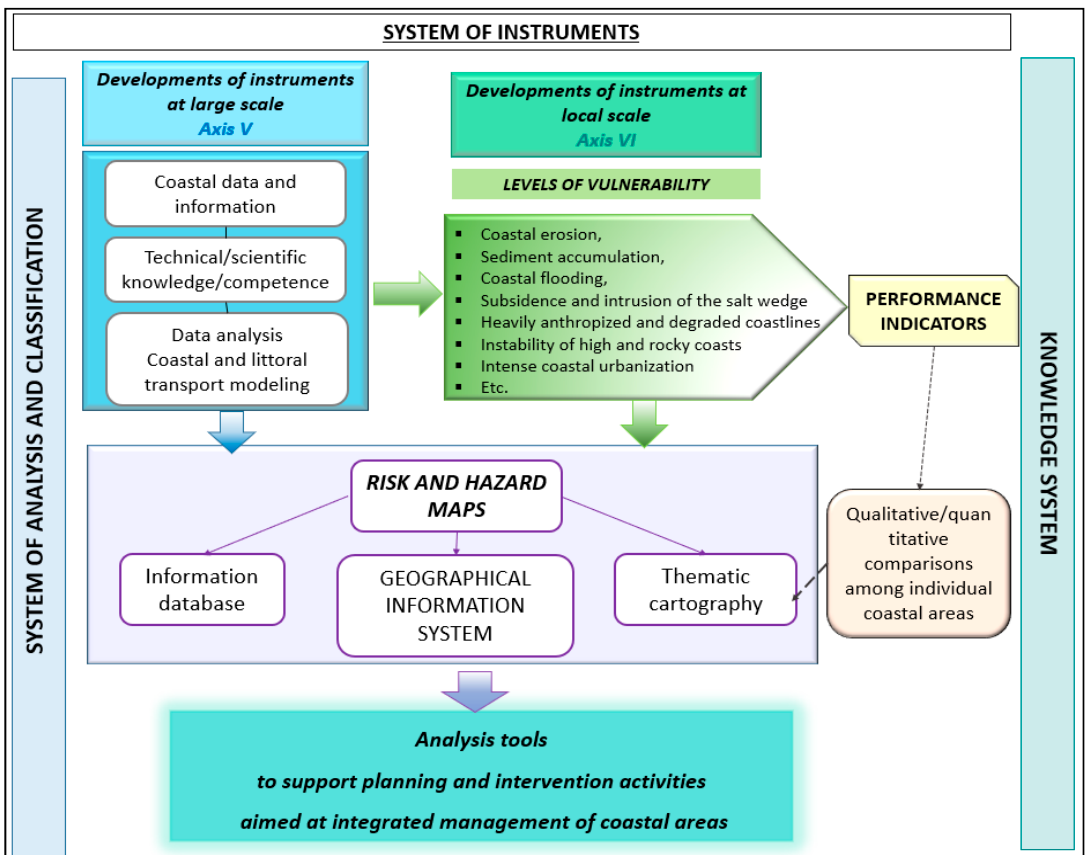
Figure 6. Schematic view of contents of the analysis and classification system.